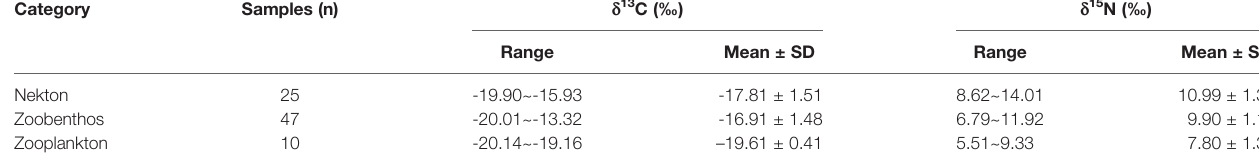
TABLE 3 | d 13 C and d 15 N values of the major prey groups of fi ve sciaenid fi sh species collected from the Zhoushan Archipelago between 2019 and 2021.